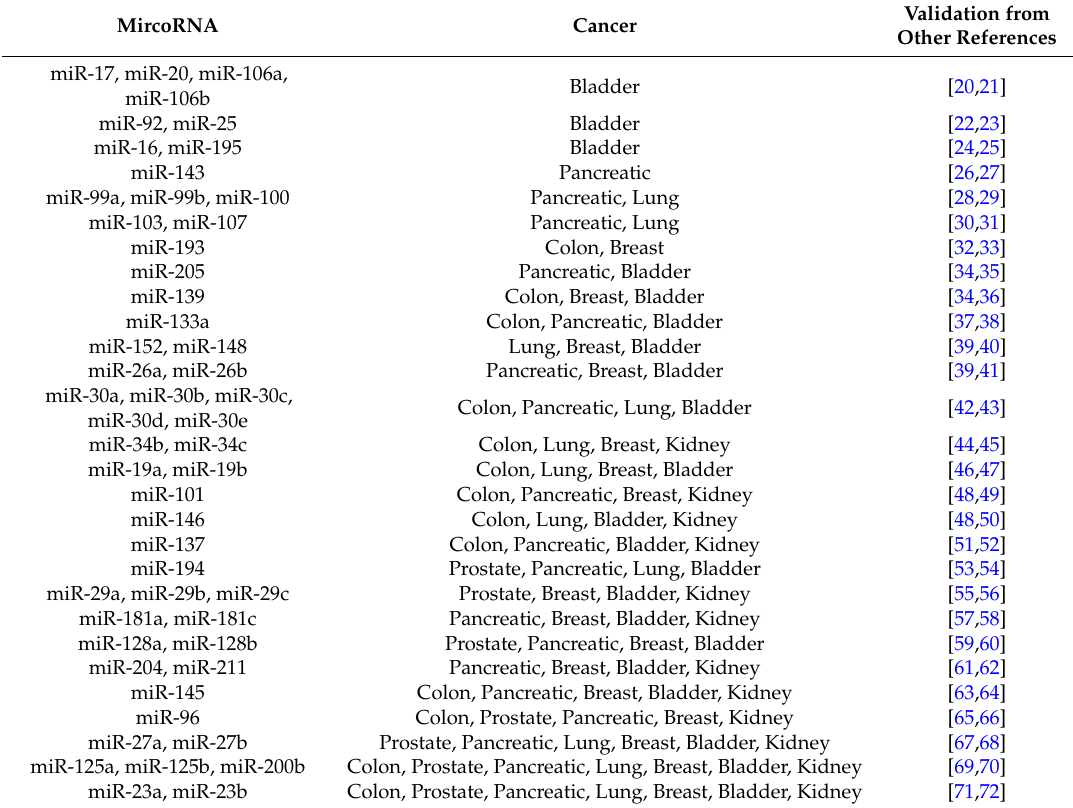
Table 1. The classification of miRNAs that are selected by the proposed method subject to cancer